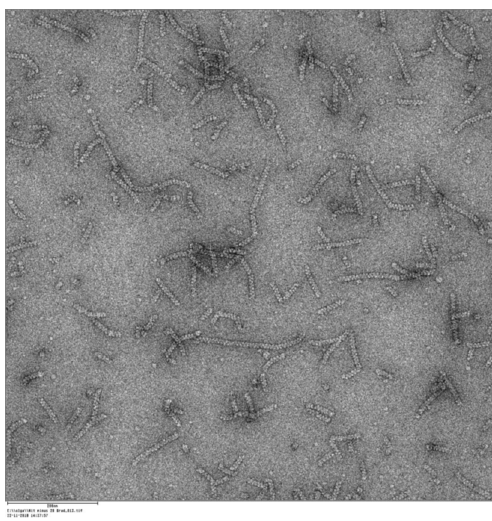
Figure 4. Electron microscopic image of the purified nitrilase from P. fluorescens EBC191 [41].